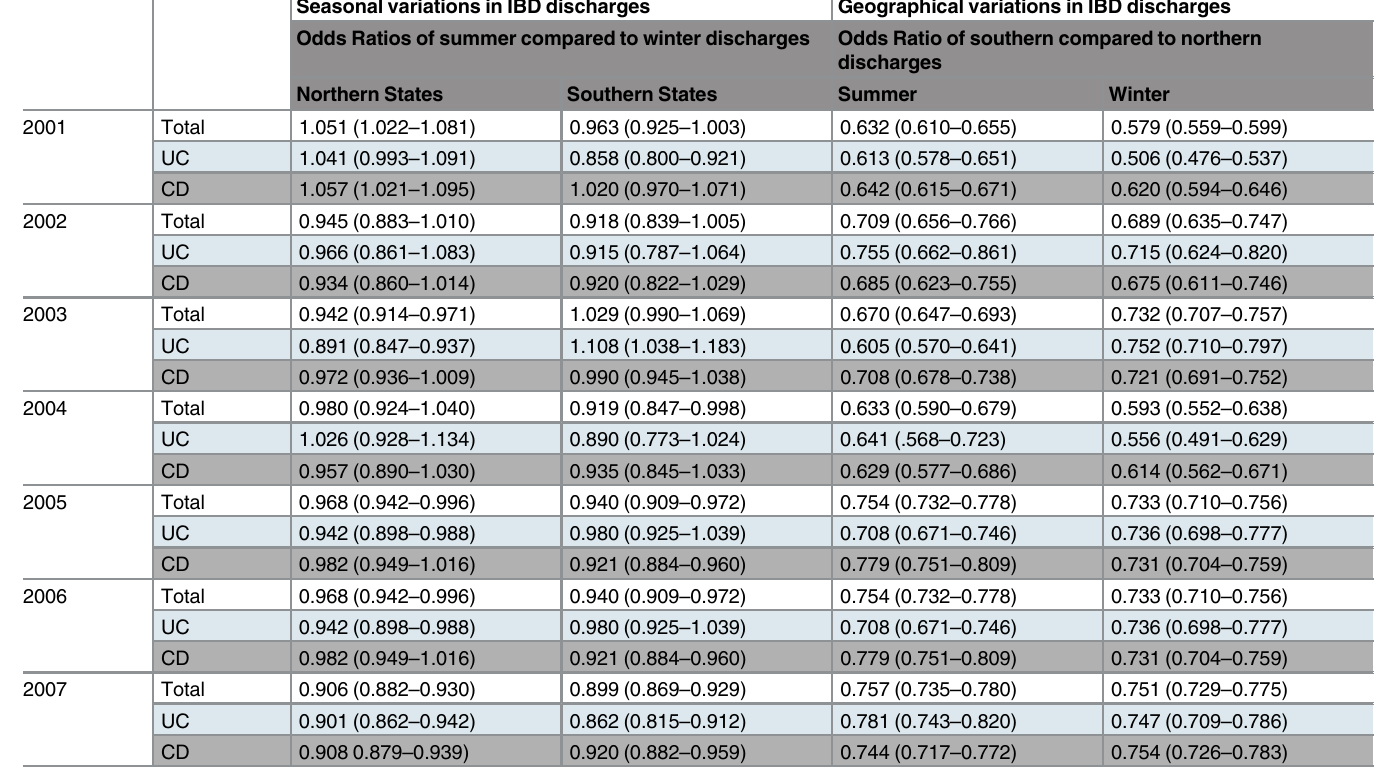
Table 2. Discharge OR comparing seasons within each region as well as geography within each season. For each year, the OR were calculated for all IBD, UC only, and CD